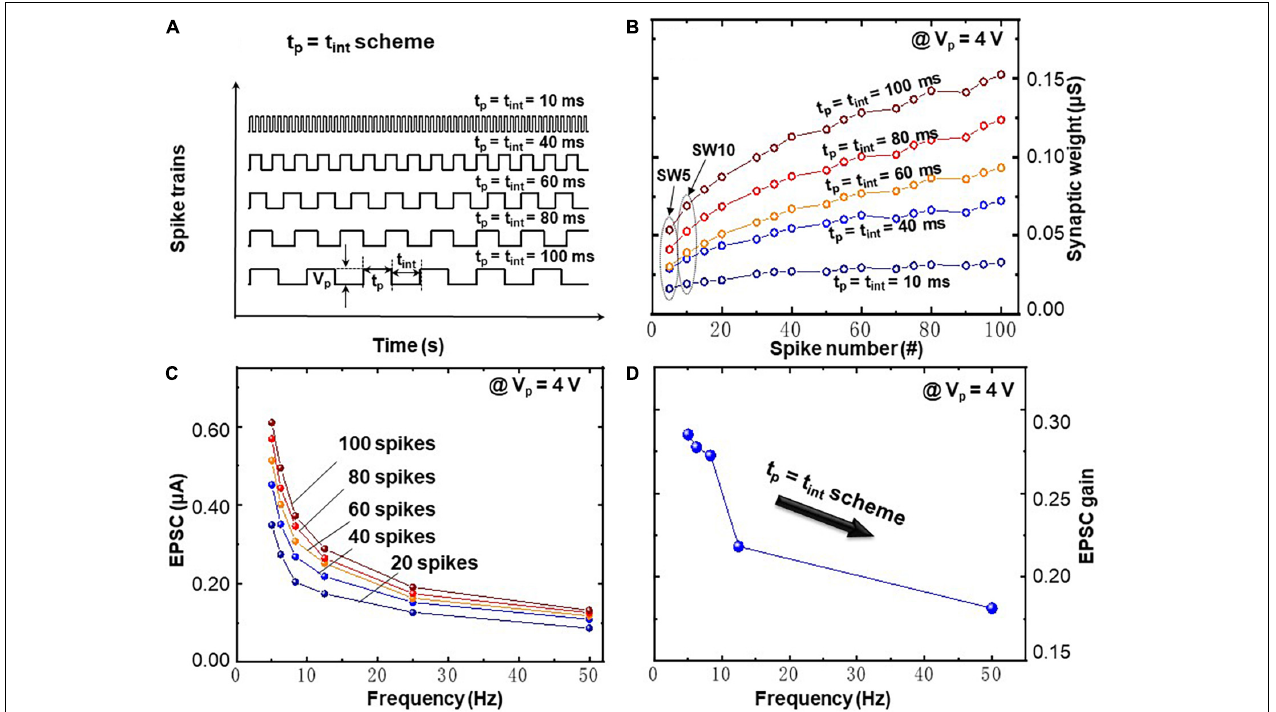
FIGURE 5 | Frequency-dependent plasticity learning rules executed by spike trains with synchronous variation of pulse width t p and time interval t int (t p = t int scheme). (A) Schematic diagram of spike trains with amplitude of V p = 4V and synchronous variation of t p = t int = 10, 40, 60, 80, and 100 ms. (B) Recorded synaptic weights as a function of spike number upon 100 consecutive spikes. (C) EPSC response triggered by spike trains (V p = 4V) and different frequencies. (D) Frequency-dependent EPSC gains at V p =